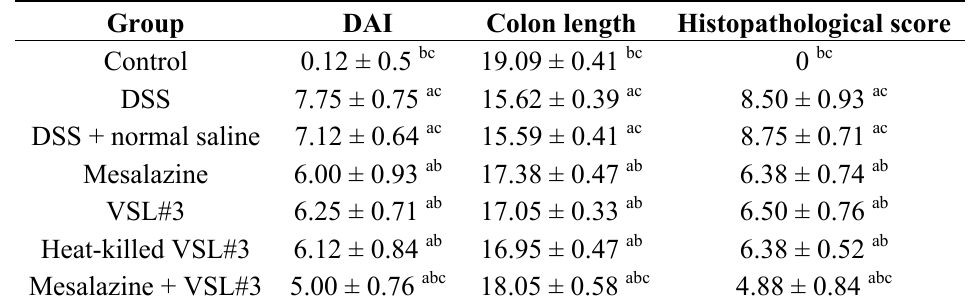
Table 1. The effect of each group on DAI, colon length and histopathological score in DSS-induced acute experimental colitis.